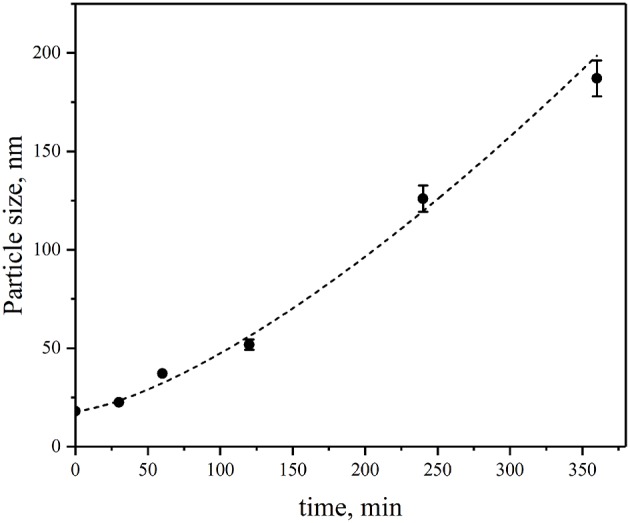
Changes in the sizes of aggregates of insulin during its incubation in the presence of CdSe/ZnS-S-PEG-OH QDs during 0.5, 1, 2, 4, and 6 h of incubation.